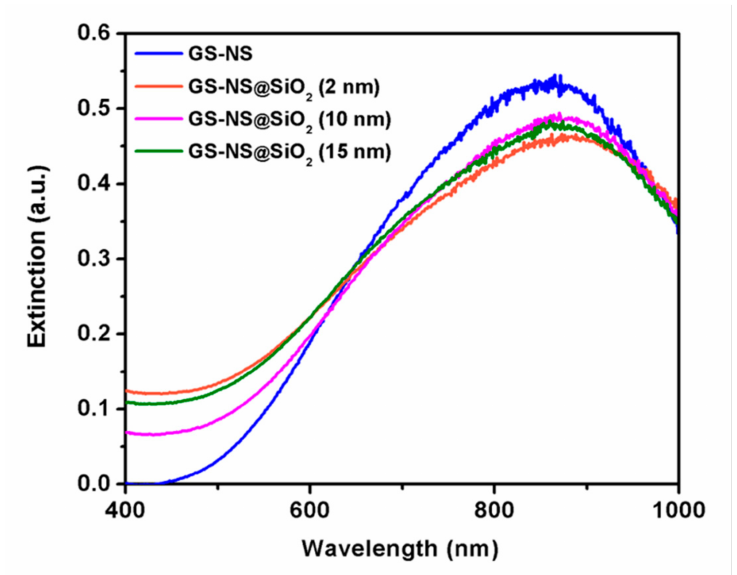
Figure 5. Extinction spectra of SiO 2 -coated GS-NS (900) with three di ff erent silica shell